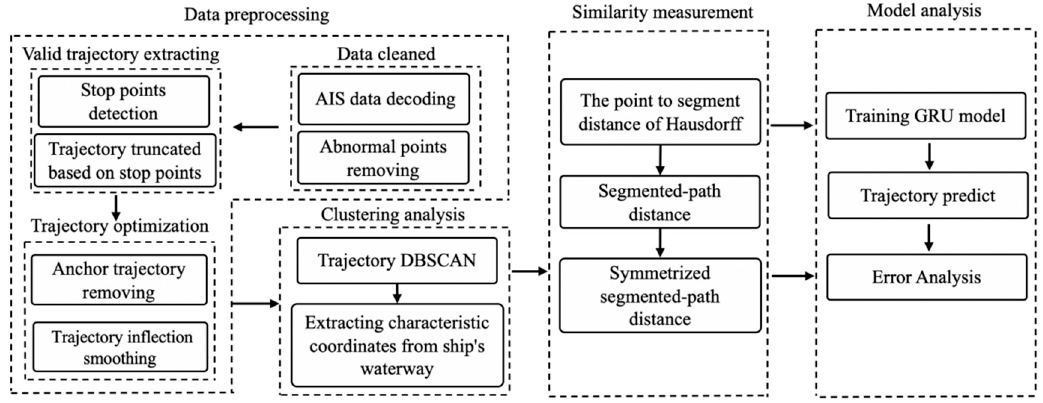
Figure 1. Flowchart of the vessel trajectory prediction framework.